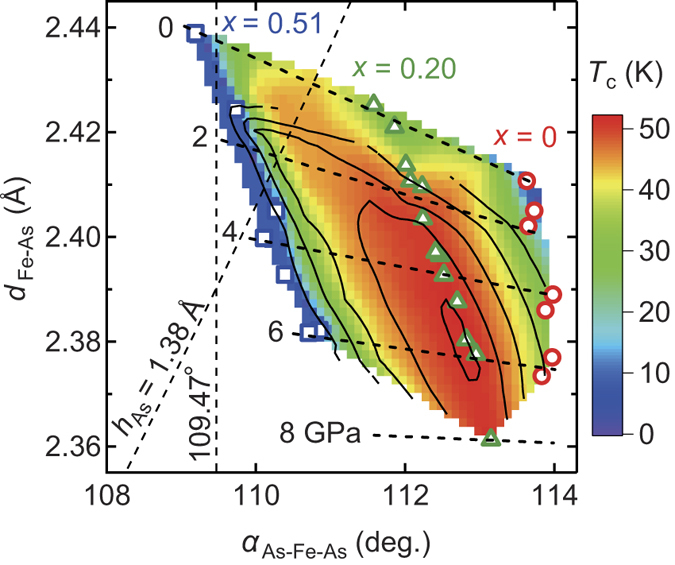
Contour plots of Tc for LaFeAsO1−xHx as a function of the As–Fe–As bond angle (αAs-Fe-As) and the Fe–As distance (dFe-As).Broken lines represent the regular tetrahedron and the As height (hAs) = 1.38 Å in FeAs4.